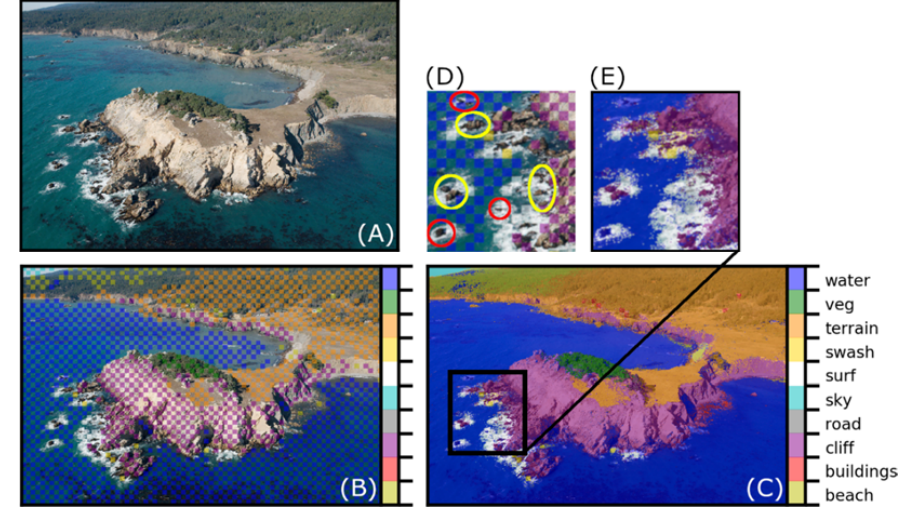
Figure 10. Classification of a typical CCR image: ( A ) Original image; ( B ) DCNN predictions; ( C ) CRF predictions; ( D ) and ( E ) show the same region (2× magnification) from the DCNN and CRF labels, respectively. The colored ellipses in ( D ) indicate small rocky areas either misclassified (red ellipses) or correctly classified (yellow ellipses).